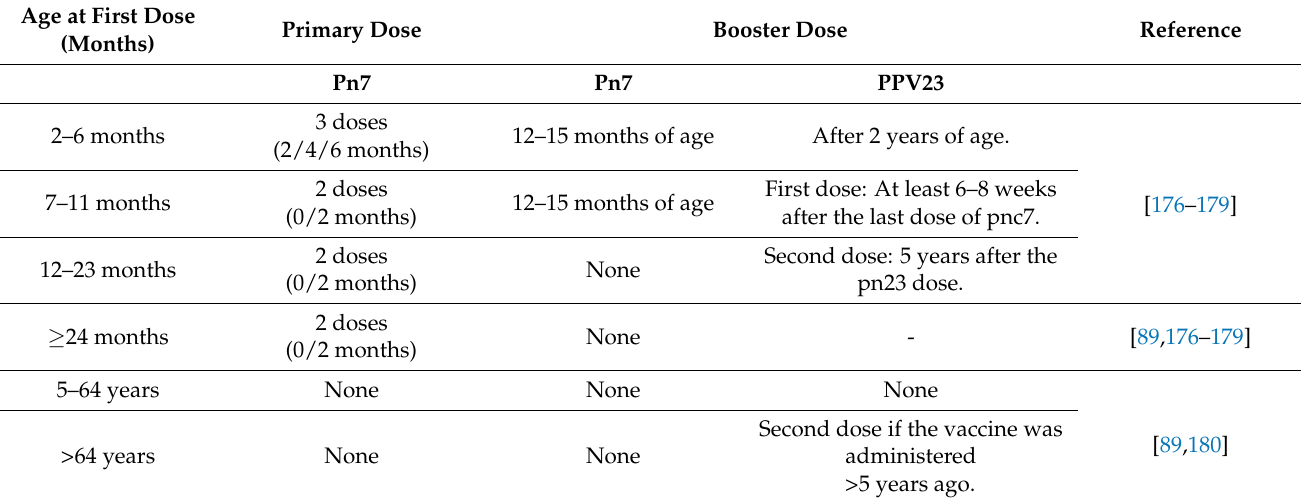
Table 3. Vaccination given to pneumococcal disease in diabetic